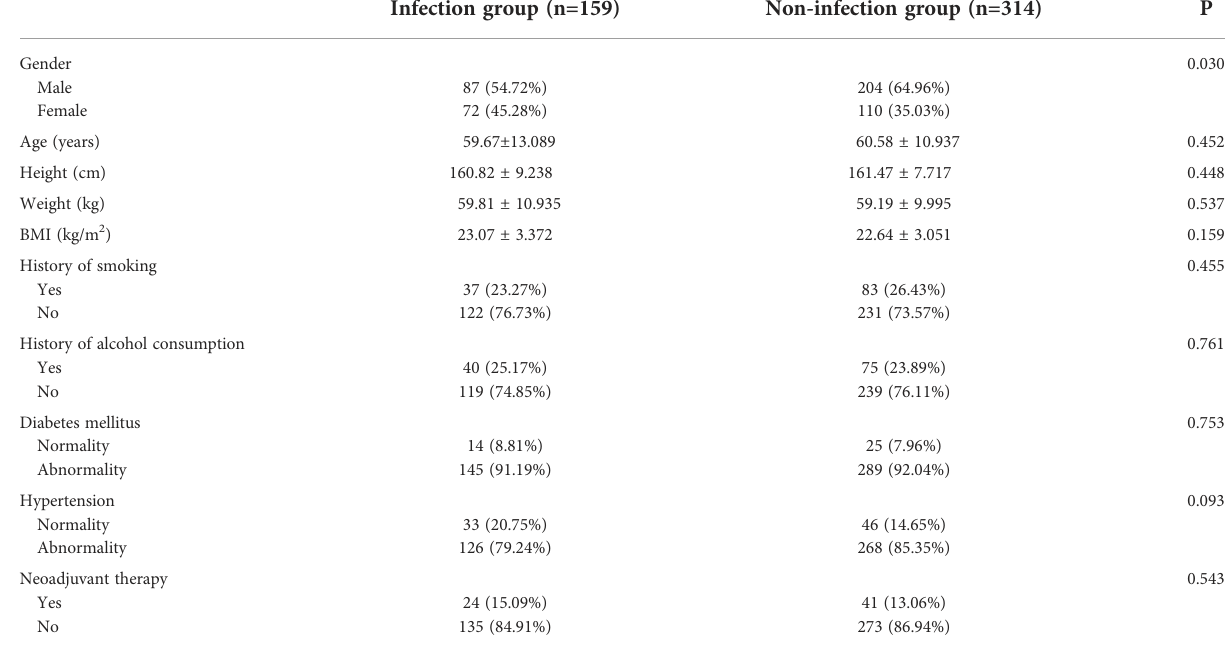
TABLE 1 Patient